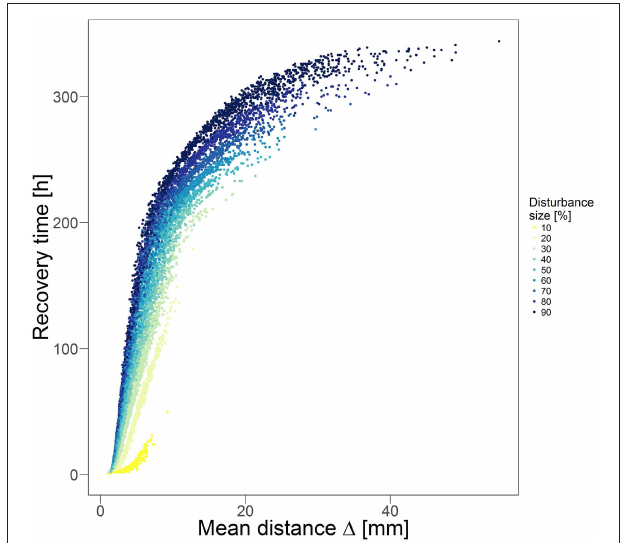
FIGURE 4 | Time for recovering 95% of biodegradation performance after disturbance events of different sizes and fragmentations over respective mean distance 1 between disturbed and nearest undisturbed habitats. Each dot indicates recovery time of one independent simulation (12,870 simulations in total). Different colors indicate different disturbance sizes (cf.